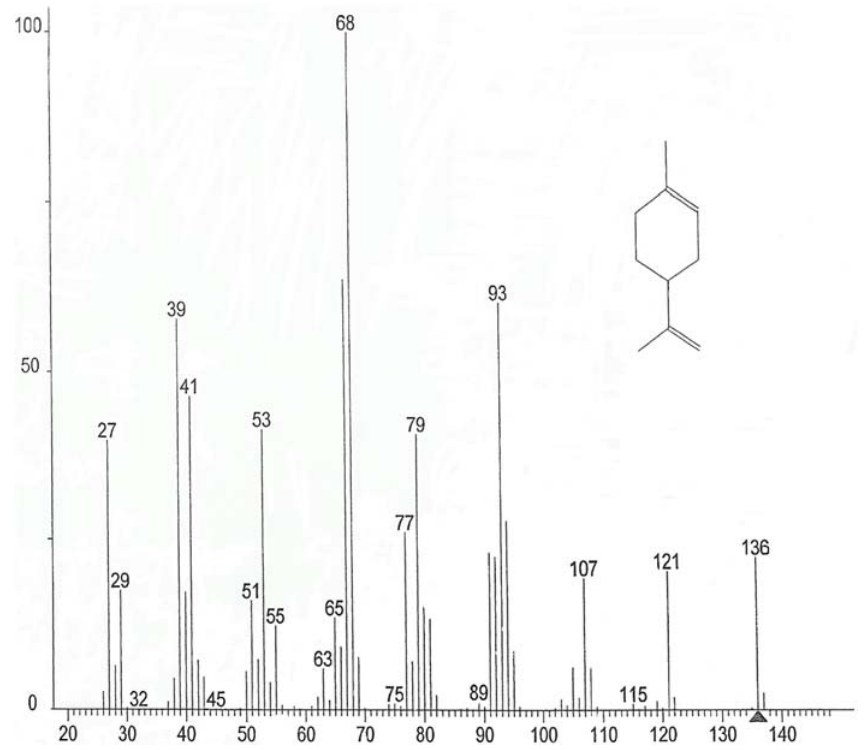
Figure 1. Mass spectra of limonene.